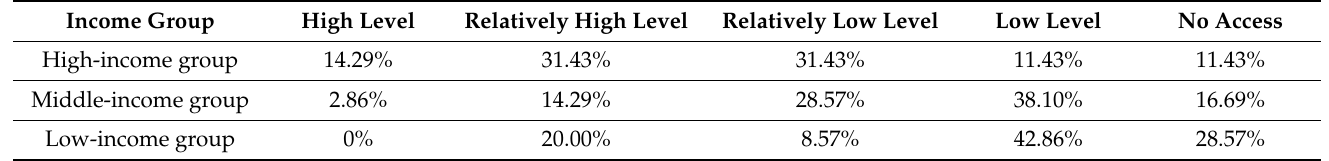
Table 10. Comprehensive level of park access among different income